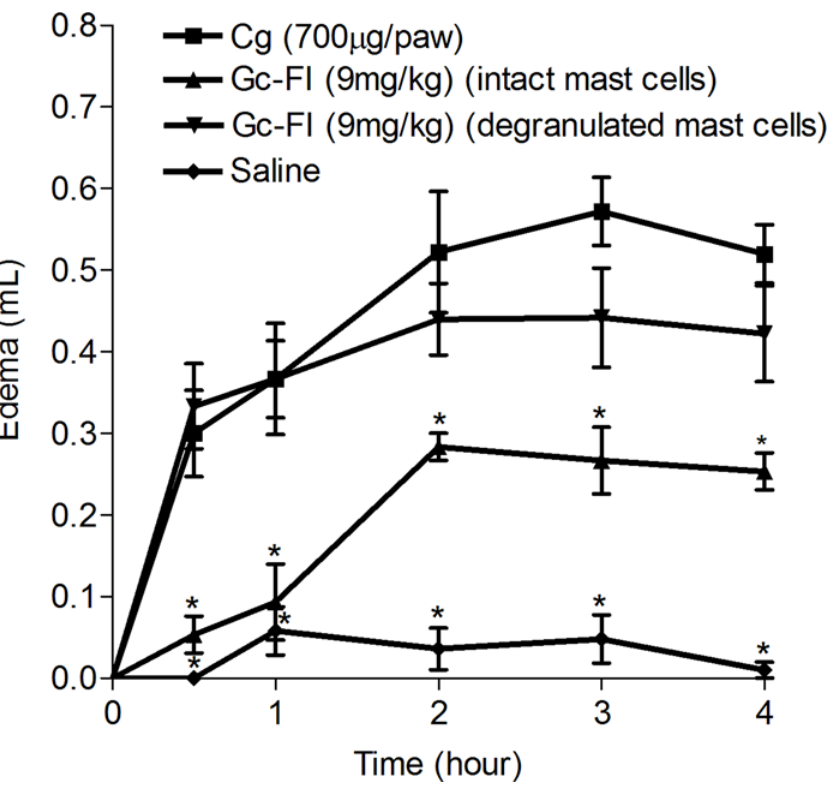
Fig 4. Effect of Gc-FI on Cg-induced paw edema in rats with intact mast cells. Mean ± S.E.M. (%, n = 6) (ANOVA, Bonferroni tests). * p < 0.05 compared with the